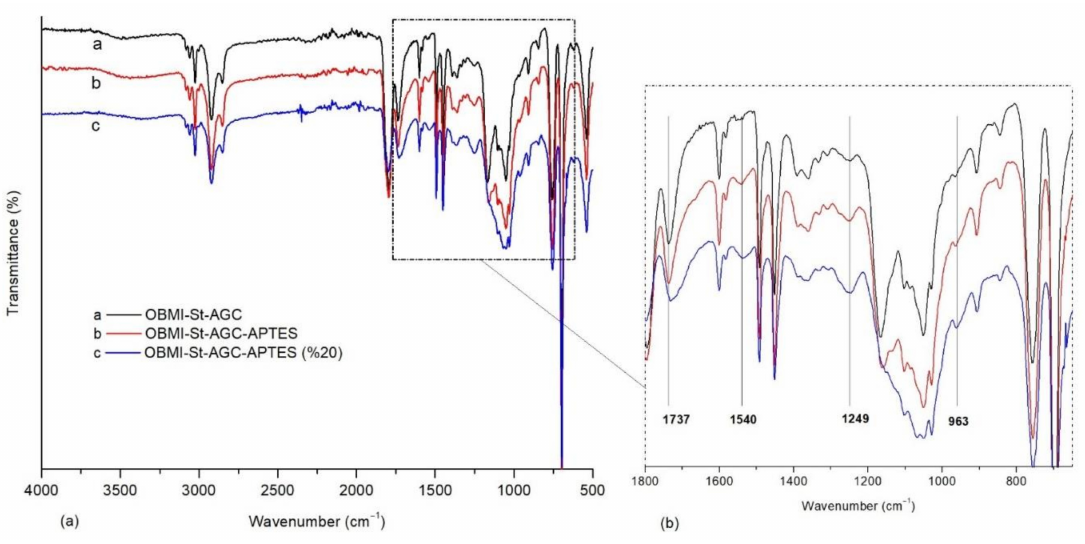
Figure 5. FTIR spectra of polymer samples ( a ); the enlarged peaks of the 1800–650 cm − 1 region ( b ). The 1 H NMR spectrum of the OBMI-St-AGC is shown in Figure 6. The peaks at 7.4–6.2 ppm are attributed to aromatic protons of styrene, and the peaks at 5.36 and 4.3–4.1 ppm represent the protons of CH-O-CO-R and CH 2 -O-CO-R groups of oil